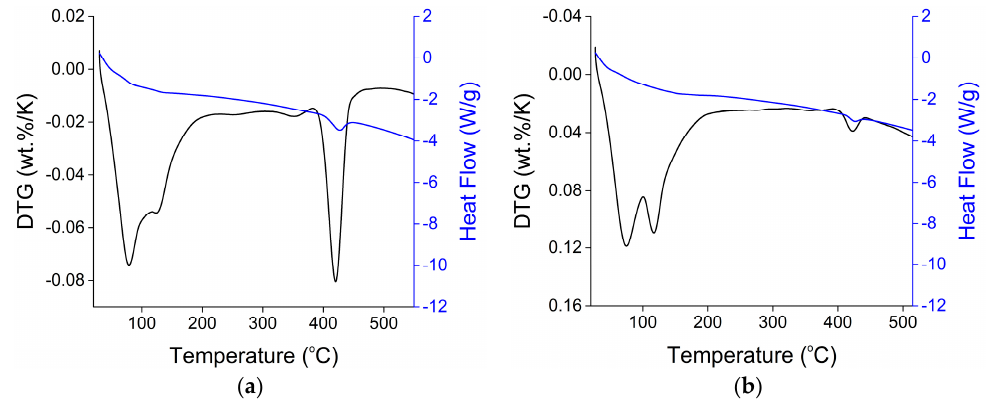
Figure 17. DTG and DSC curves in 12% OPC mortars stored in ( a ) saturated limewater; ( b ) 10% Na 2 SO 4 solution.